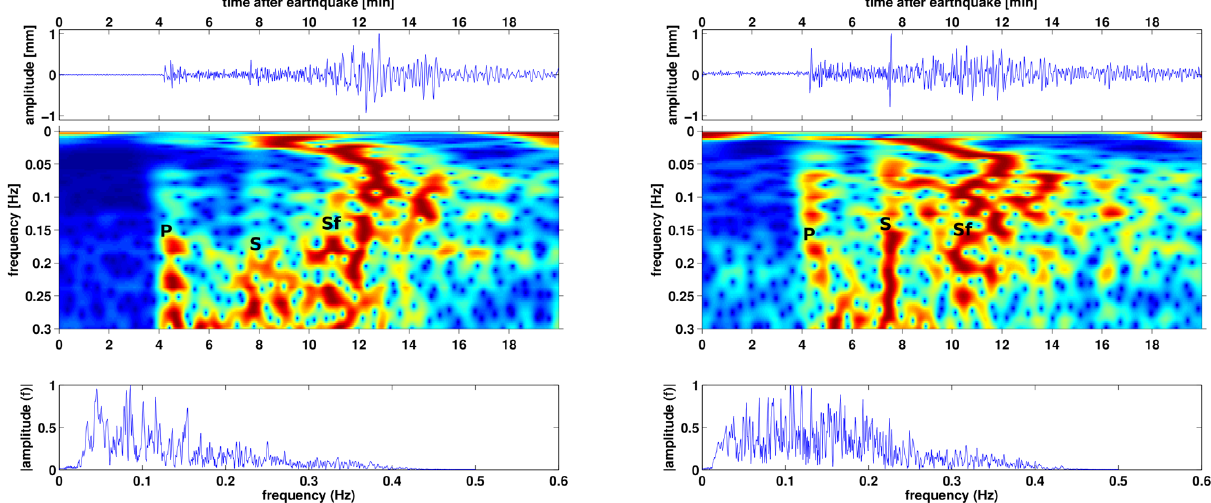
Figure 15. Multiple filter technique time–frequency spectra computed for vertical component data of the shallow 2004 western Crete (left) and intermediate-depth 2002 Milos event (right) recorded at station MOX of the German Regional Seismic Network (GRSN). In each subfigure, the top panel shows the data trace, the central panel displays the time–frequency spectrum and the bottom panel shows the amplitude spectrum of the trace.